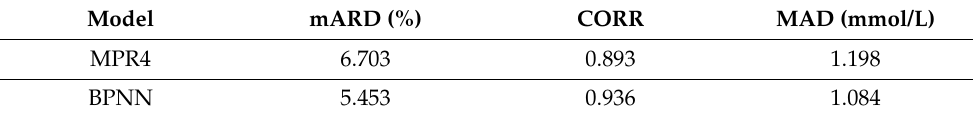
Table 1. The performance of the two models for statistical analysis.